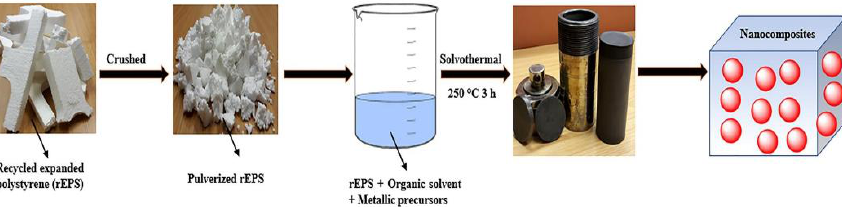
Figure 17. Synthesis scheme via the solvothermal method for hybrid nanocomposites. Reprinted with permission from ref. [51].